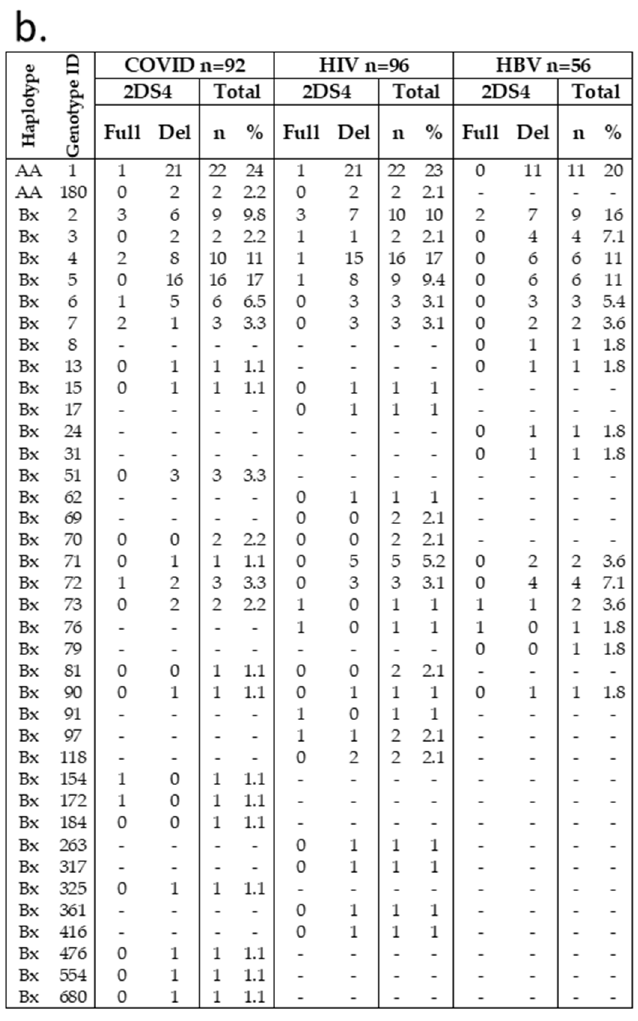
Figure 1. Genotype frequencies in infected Sicilian cohorts. ( a ) KIR genotype diversity in our infected cohorts. The presence or absence of a KIR gene is indicated by grey and white boxes, respectively. ( b ) Carrier frequencies of the KIR genotype in each cohort were determined as their percentages of the total number of individuals. Genotype ID refers to genotype classification according to allelefrequencies.net. aKIR, activating KIR; Del, delete variant of KIR2DS4 ; Full, full-length variant of KIR2DS4 ; iKIR, inhibitory KIR; Pseudo, pseudogene.